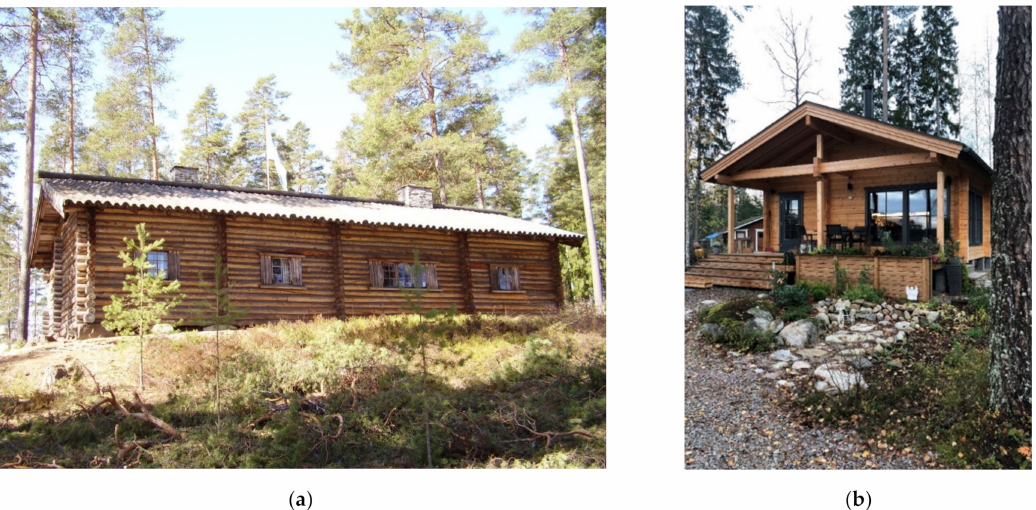
Figure 5. Log cottage examples from Finland: ( a ) a hunting lodge of Marshal Mannerheim in Loppi (source: Wikipedia, https://commons.wikimedia.org/wiki/File:Mannerheim_hunting_house. JPG#filelinks (accessed on 29 January 2022)); ( b ) a recently built log cottage with modern large windows but also traditional elements such as a gable roof and decorative mullions (Photo courtesy of Lotta